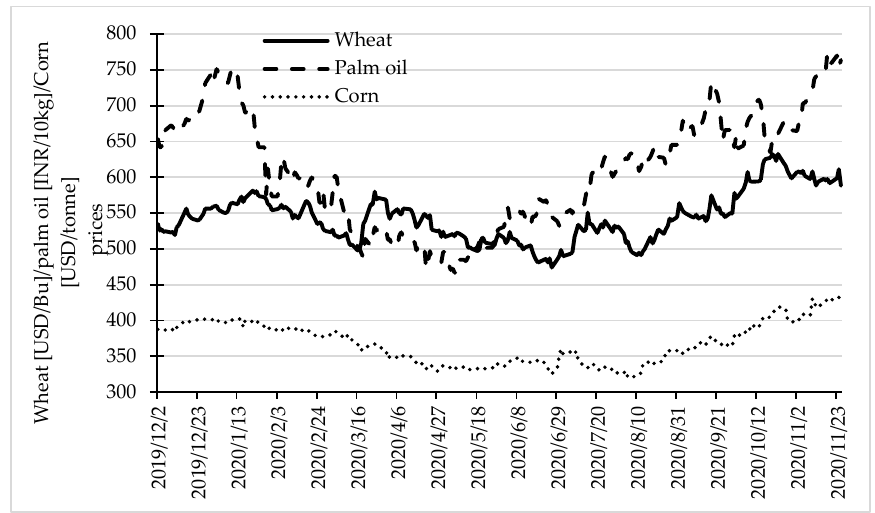
Figure 4. Wheat, palm oil, and corn prices in the period 2 December 2019–26 November 2020. Source: